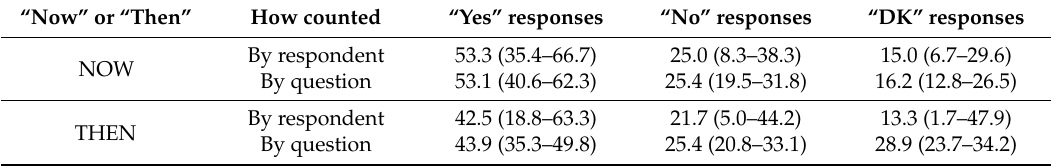
Table 2. Medians and IQRs of “Yes”, “No” and “Don’t know” (DK) answers to the 60 main survey questions, as percentages of total possible counts (60 by respondent, 114 by